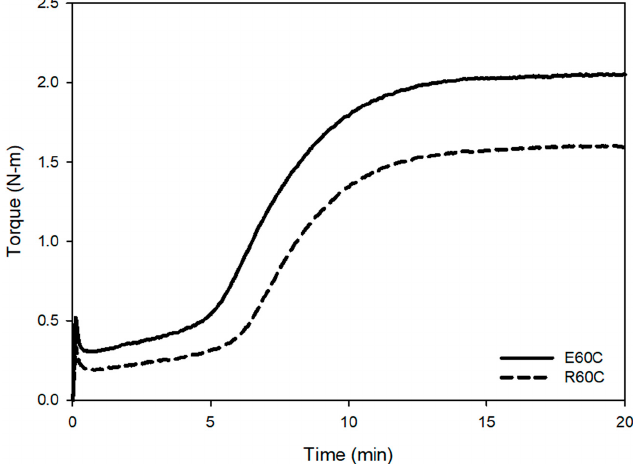
Figure 6. Cure characteristics of emulsion styrene butadiene rubber (ESBR) and reversible addition-fragmentation radical transfer (RAFT) ESBR carbon black-filled compounds.